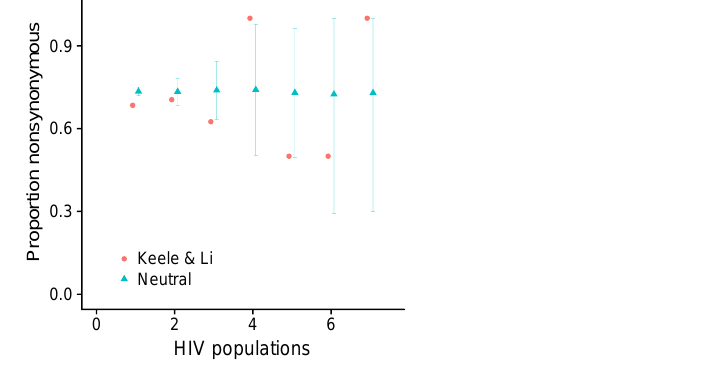
Figure 3. Private mutations show lower proportions of non-synonymous mutations than expected by chance. The proportion of synonymous mutations in the Keele and Li data compared to a neutral model (randomly distributed mutations,1000 simulations). For each randomization the number of mutations in each convergence category (x-axis) was kept constant. A “—“ means there is no significant difference between the neutral model and the Keele and Li data, whereas a “*” means that the proportion of non-synonymous mutations in the Keele and Li data was lower in at least 950 out of 1000 simulations. Mutations in overlapping reading frames are excluded. The error bars show standard deviations.